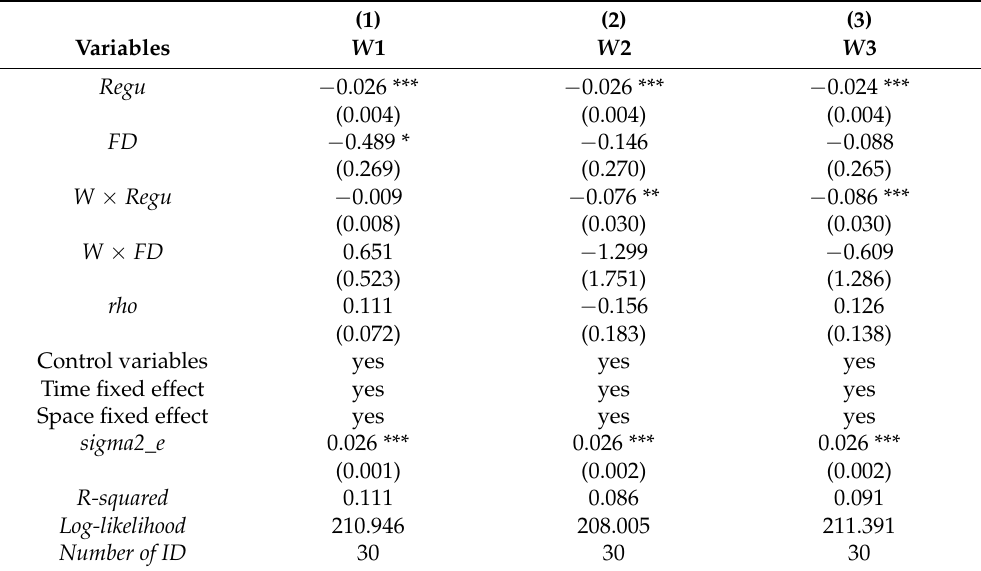
Table 10. Robustness test results under each spatial weight matrix of replacement carbon emission index.